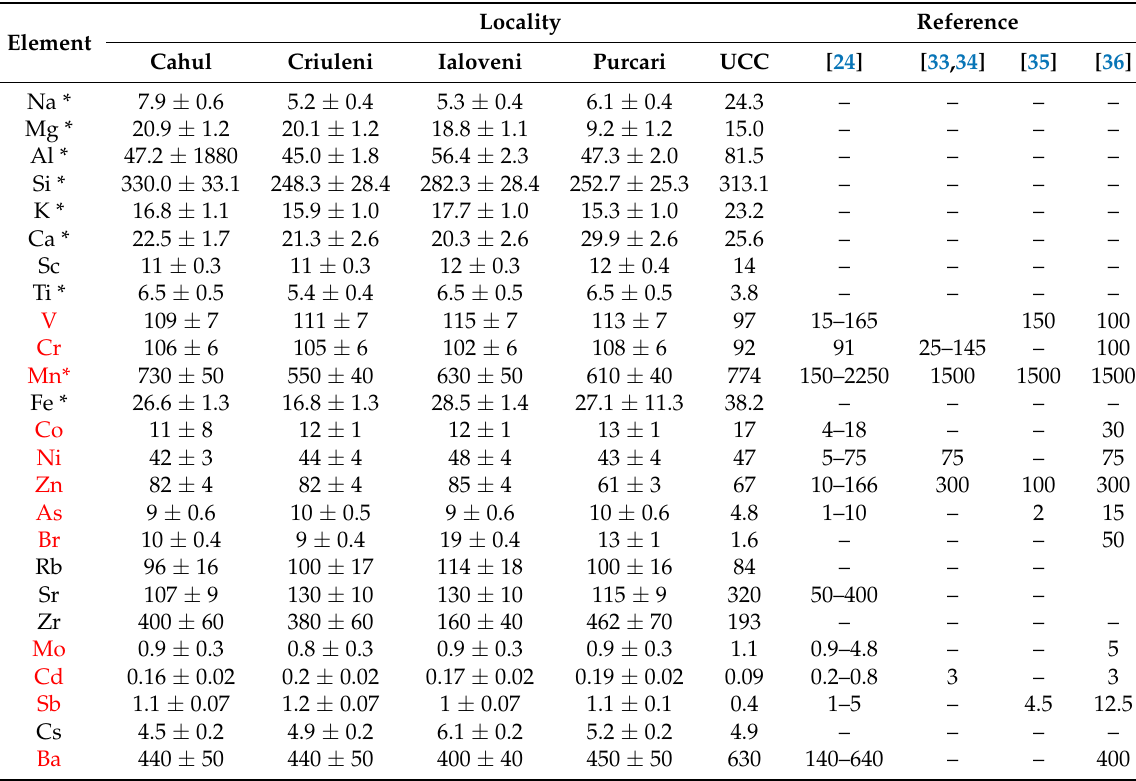
Table A1. The mass fractions ± total experimental uncertainty of analyzed soil elements. For comparison, the corresponding values of the UCC [23], Moldavian Average Soil (MAS) [24], as well as National Reference Limits (NRL) for the Republic of Moldova [33,34], the Russian Federation [35], and Romania [36] are reproduced as well. Mass fractions expressed in mg kg − 1 except major elements marked by *, the mass fractions of which are expressed in g kg − 1 . The elements considered as potentially hazardous according to [33–36] are marked with red color. Total experimental uncertainty was calculated by composing the statistical error concerning the γ -ray spectrum area for individual lines with the reference material and neutron flux